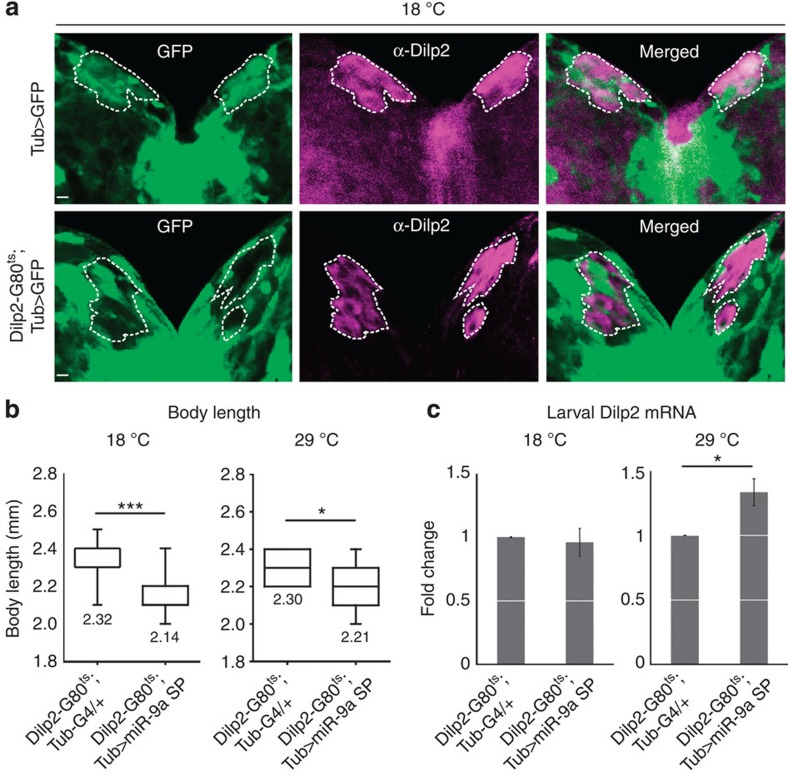
miR-9a
inside and outside the IPCs
differentially affects body growth.(a) At the permissive temperature of 18 °C, the Dilp2-Gal80ts transgene blocks ubiquitous GFP expression (Tub>GFP) in the larval IPCs, as indicated by anti-Dilp2 staining (magenta). (b,c) Suppression of miR-9a expression outside the IPCs (Dilp2-G80ts; Tub>miR-9a sponge, 18 °C) significantly reduces body length but does not affect Dilp2 expression. When Dilp2-Gal80ts is inactivated at 29 °C and miR-9a is ubiquitously suppressed (Dilp2-G80ts; Tub>miR-9a sponge), body length is less significantly reduced but Dilp2 expression is increased. Data are presented as mean±s.e.m. from at least three independent experiments. Statistical significance was assessed by two-tailed Student's t-test, *P<0.05, ***P<0.001. Scale bar, 10 μm.